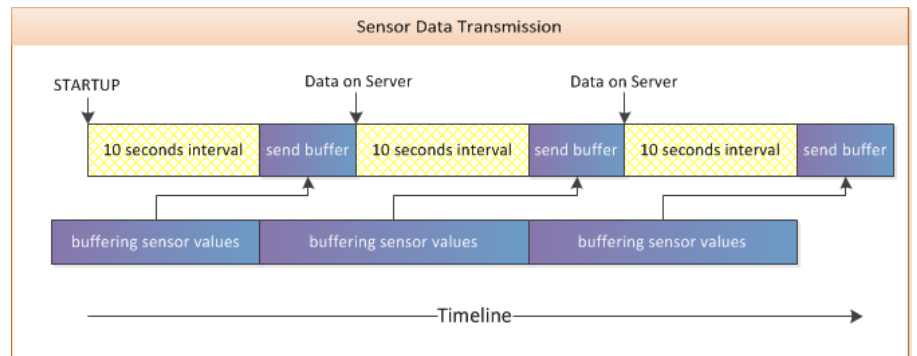
Figure 7. Sensor data transmission